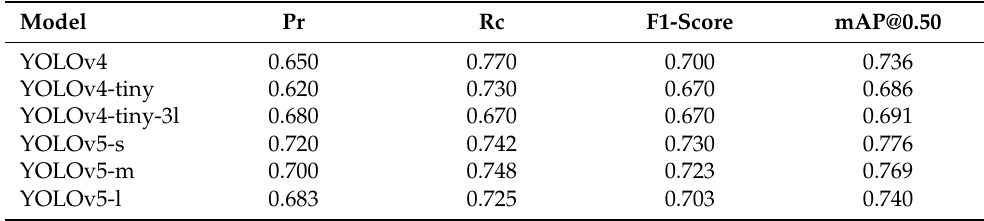
Table 7. Test set metrics for a confidence of 0.25 and IoU of 0.50.